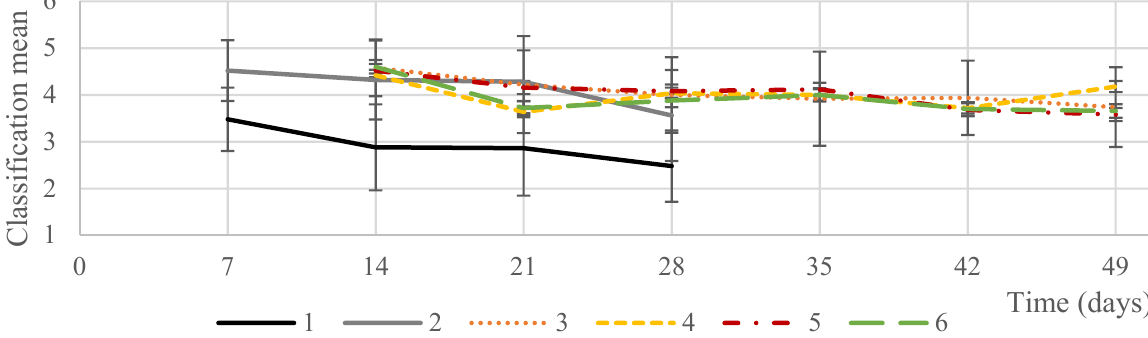
Figure 4. Stem aspect evolution (N = 50) expressed as mean values of the visual classification. Classification (Figure 3, Materials and methods) ranged from 1 (completely brown and dehydrated stem) to 5 (completely green and fresh stem). Treatment 1 was located at FO under normal atmosphere conditions. Treatments 2 to 6 were located at RC. Treatment 2 was under normal atmosphere conditions. The atmosphere compositions of treatments 3 to 6 were, respectively, 3%O 2 –10%CO 2 , 3%O 2 –15%CO 2 , 10%O 2 –10%CO 2 and 10%O 2 –15%CO 2